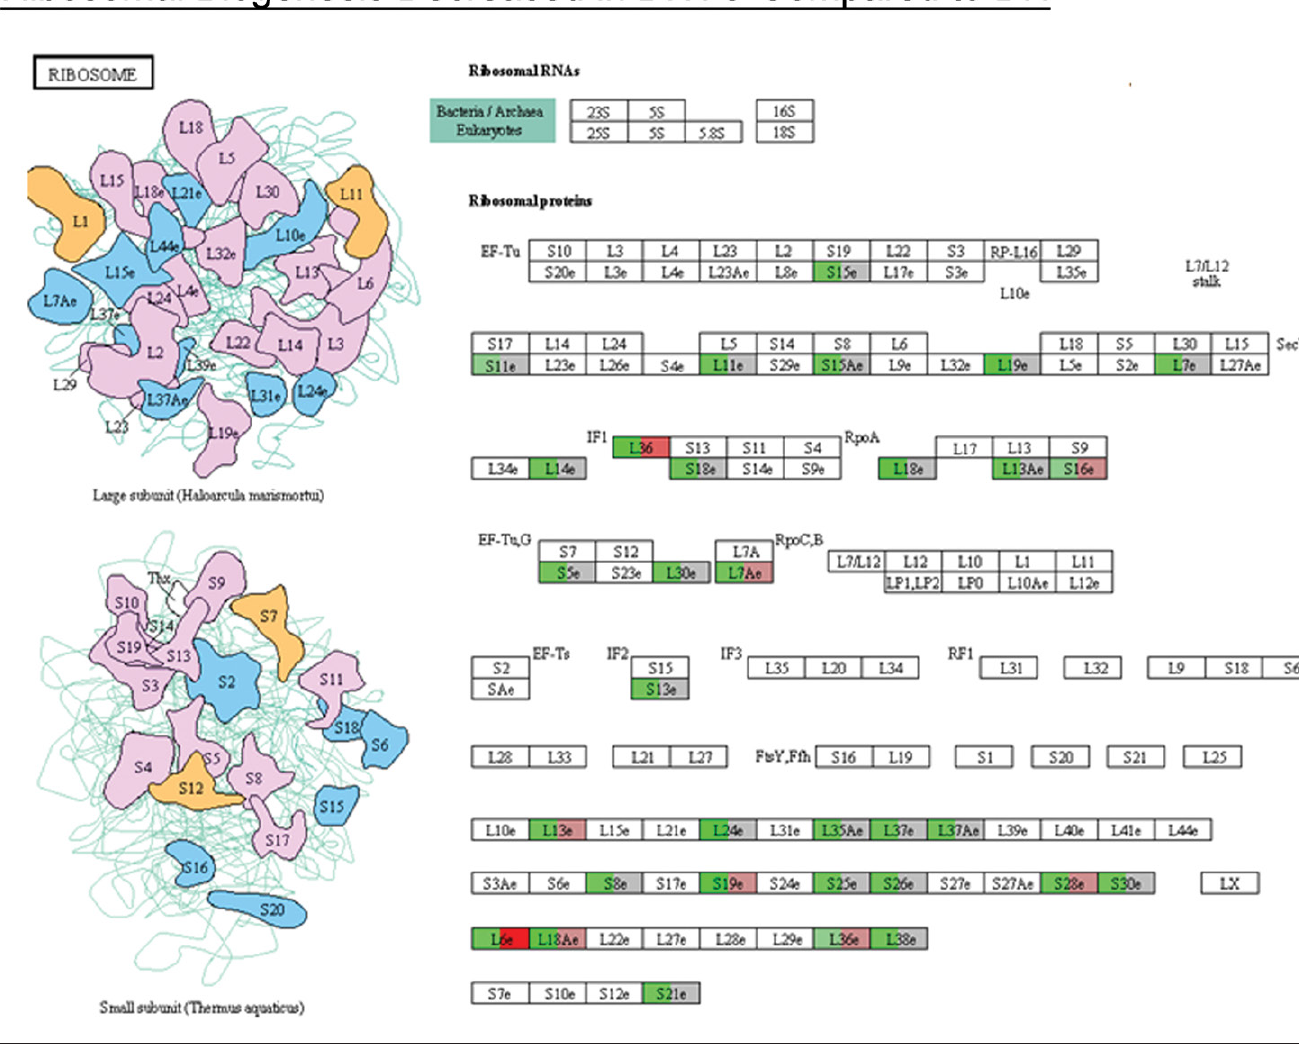
Figure 7. TO reverses increased protein synthesis pathways in the DH lung. The processes downregulated in DHTO compared with DH involved protein synthesis, protein trafficking and ribosomal biogenesis. The ribosomal biogenesis KEGG pathway demonstrates reduced expression of many ribosomal genes in DHTO / DH (32,33). Differentially expressed genes are colored, with the left half color indicating expression change in DHTO versus Control, and right half DH versus control. Red boxes indicate upregulated genes, green boxes downregulated genes, and gray boxes expressed genes without different mRNA levels. White boxes indicate genes that did not meet our inclusion